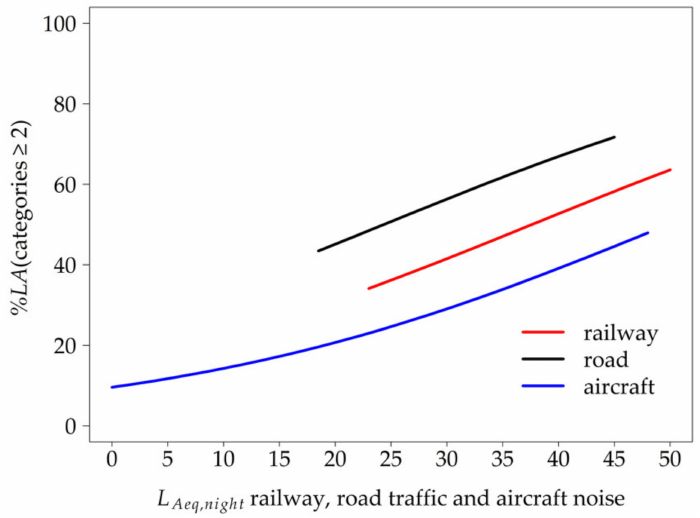
Figure 4. Probability to be annoyed at least a little ( %LA ) by nocturnal road traffic, railway, and aircraft noise expected by model GEE 5 as a function of the L Aeq,night measured inside the bedroom adjusted for general adaption to chronic noise exposure (median = 3).